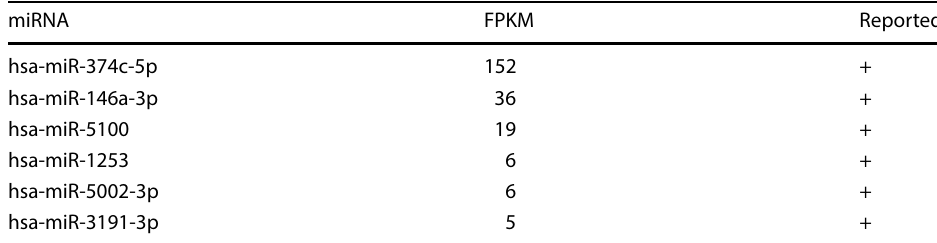
the specified transcripts are not indicated in any cancer-related